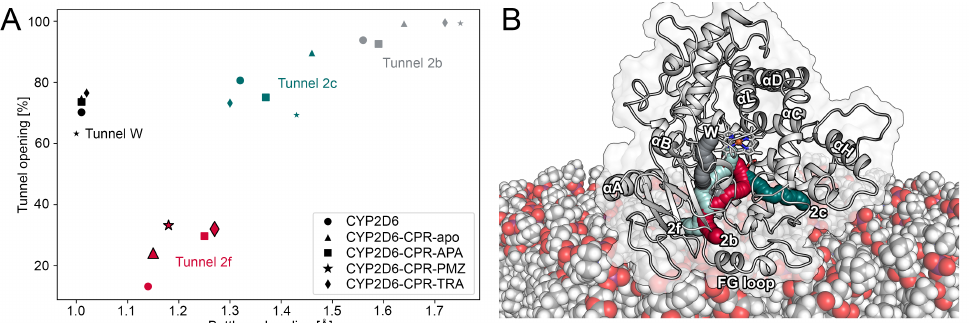
Figure 5. Results of tunnel computation. ( A ) The average bottleneck radii and relative opening times of nine different tunnels in CYP2D6. Symbols with increased size and with an outline indicate that the represented opening time differs significantly (at a significance level of 0.05) from the corresponding value of free CYP2D6. ( B ) Depiction of tunnels in